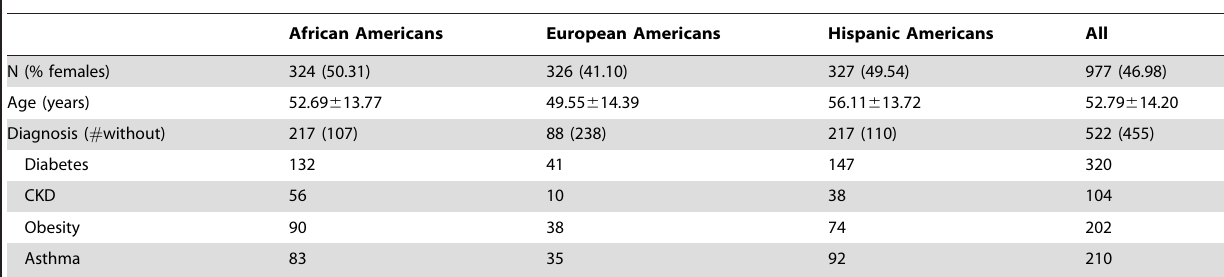
Table 1. Characteristics of subjects.